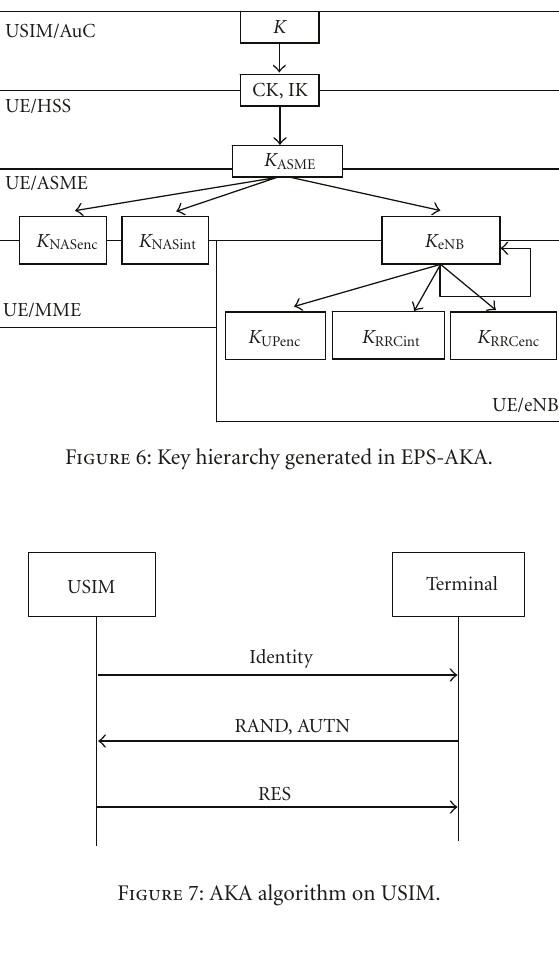
Figure 5: EPS AKA.